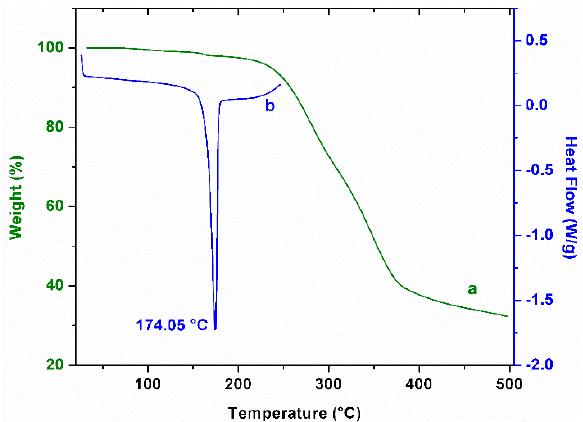
Figure 2. Thermal analysis of curcumin. Thermogravimetric analysis ((a), green line) and differential scanning calorimetry ((b), blue line). Melting point of curcumin is indicated at 174.05 °C.